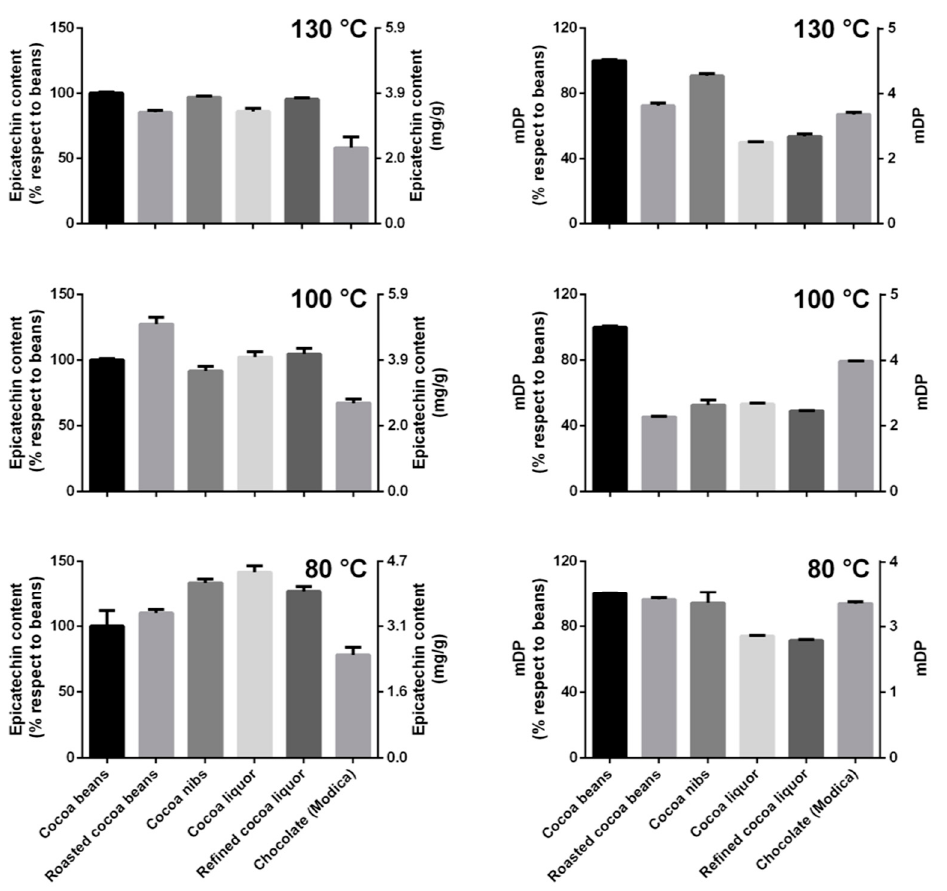
Figure 5. Epicatechin content determined by HPLC ( left plots) and mDP data determined by using the phloroglucinol derivatization method ( right plots).